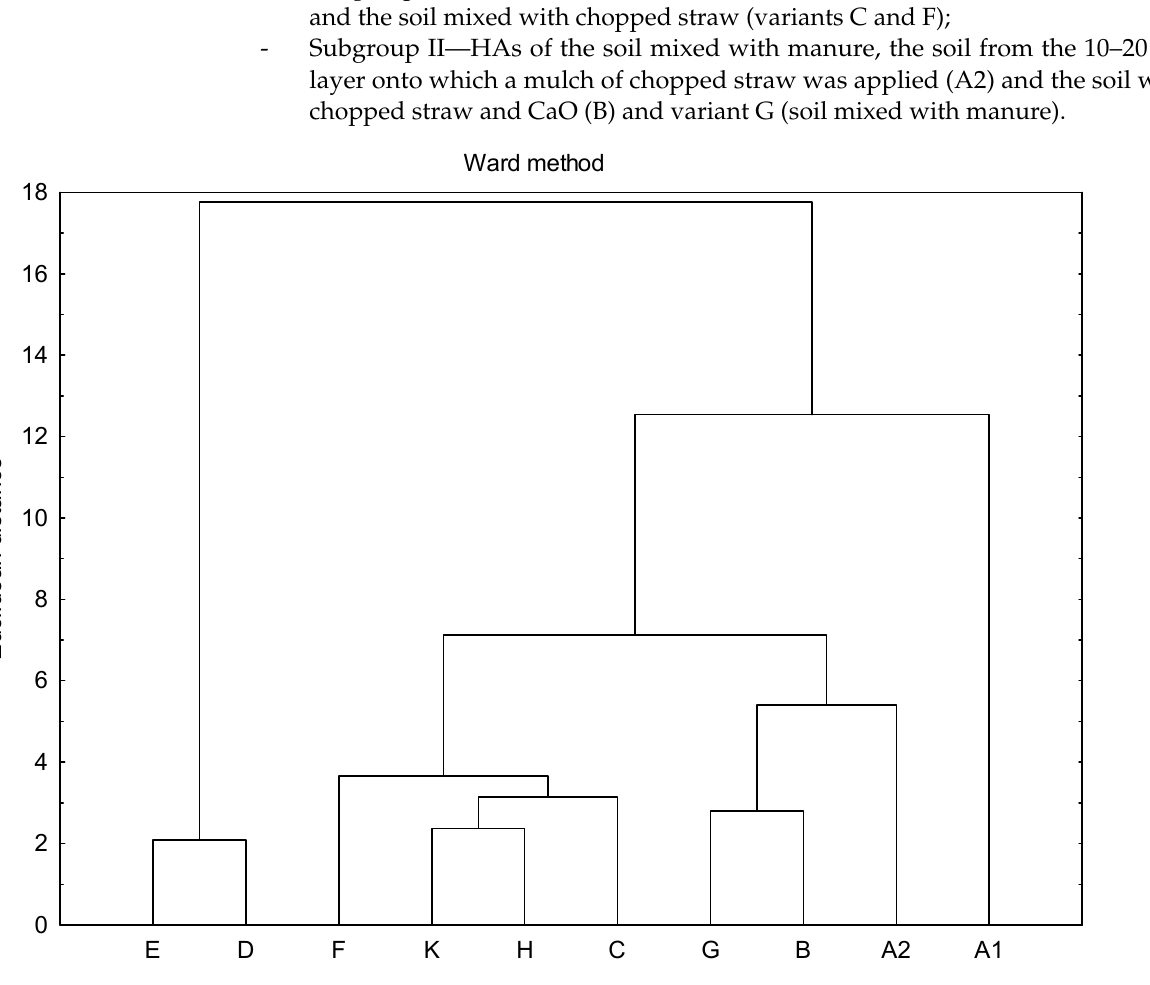
Figure 5. Cluster analysis determined based on humic acid parameters.